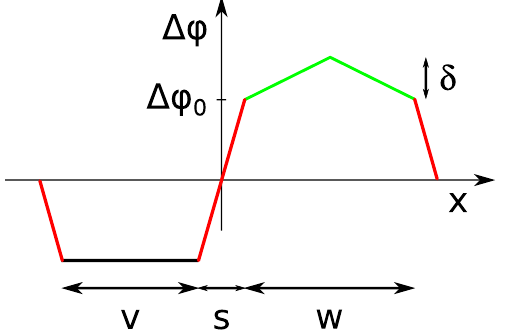
Figure 2. Modeling of the phase profile of an ion-exchanged grating by the polygonal model.